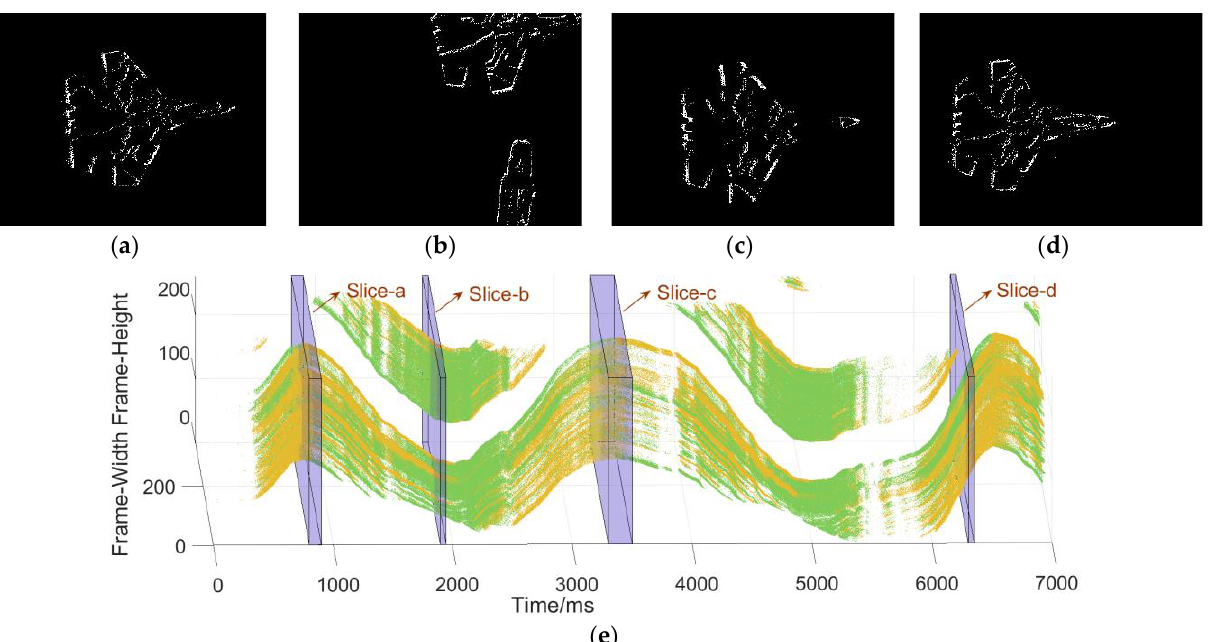
Figure 4. ( a – d ) are virtual frames constructed by adaptive slicing from the spatiotemporal event stream ( e ). When the number of objects changes or the speed of objects changes, our method can select appropriate slices from the rapidly changing event stream to construct a virtual frame without motion blur and information loss; ( e ) the spatiotemporal distribution of event stream caused by moving object.